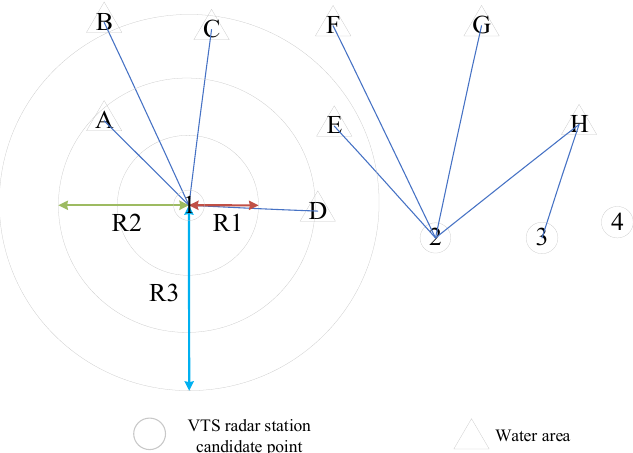
Figure 1. VTS radar station location process.